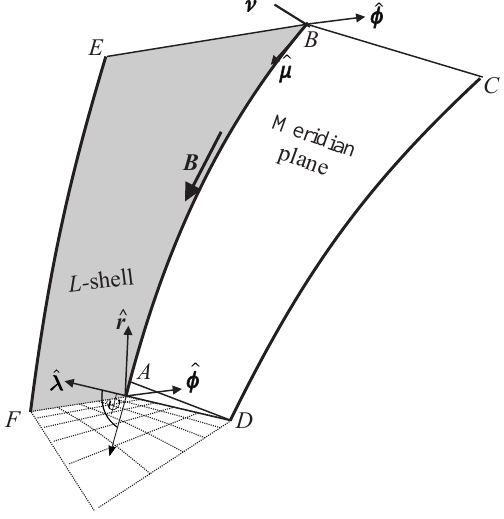
Figure 1. Dipole field: directions of unit vectors.